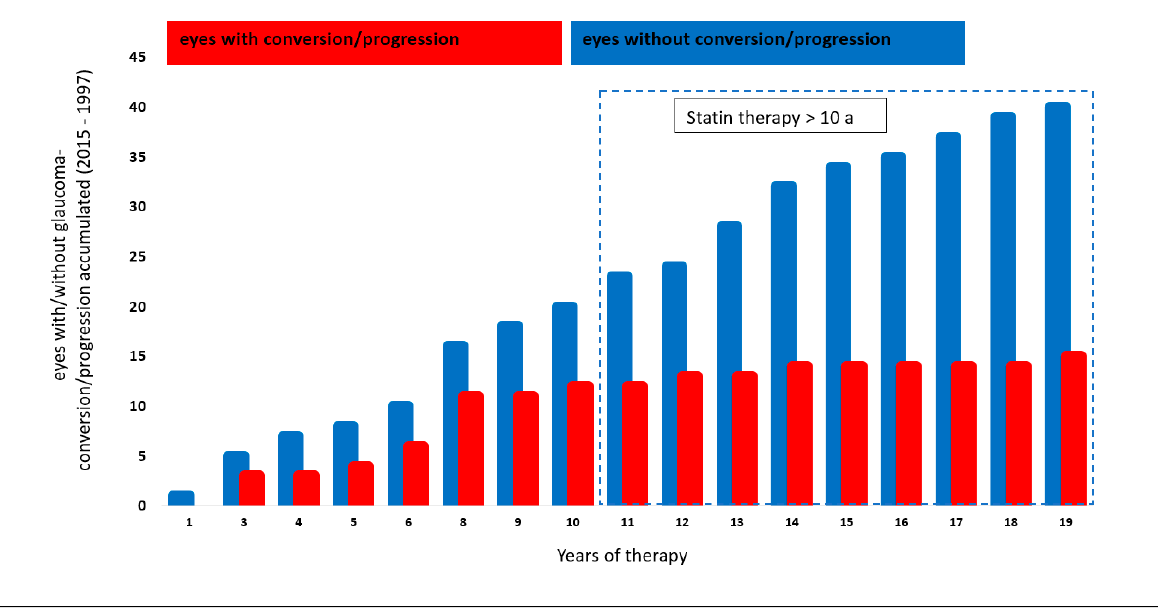
Figure 2. Effect of statin therapy on glaucoma conversion and glaucoma progression.